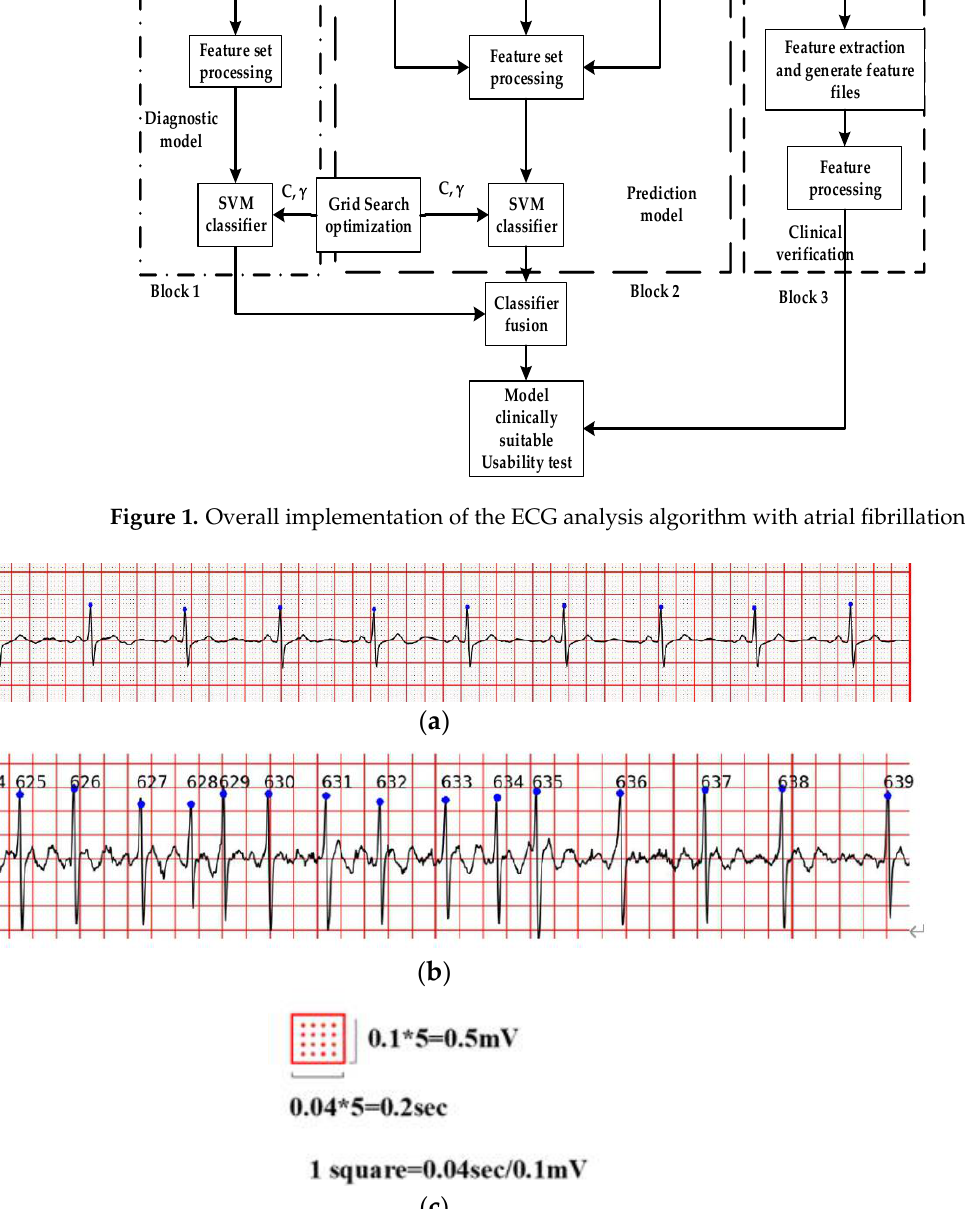
Figure 2. ( a ) Normal ECG, ( b ) atrial fibrillation ECG; ( c ) is the scales of ( a ) and ( b ).